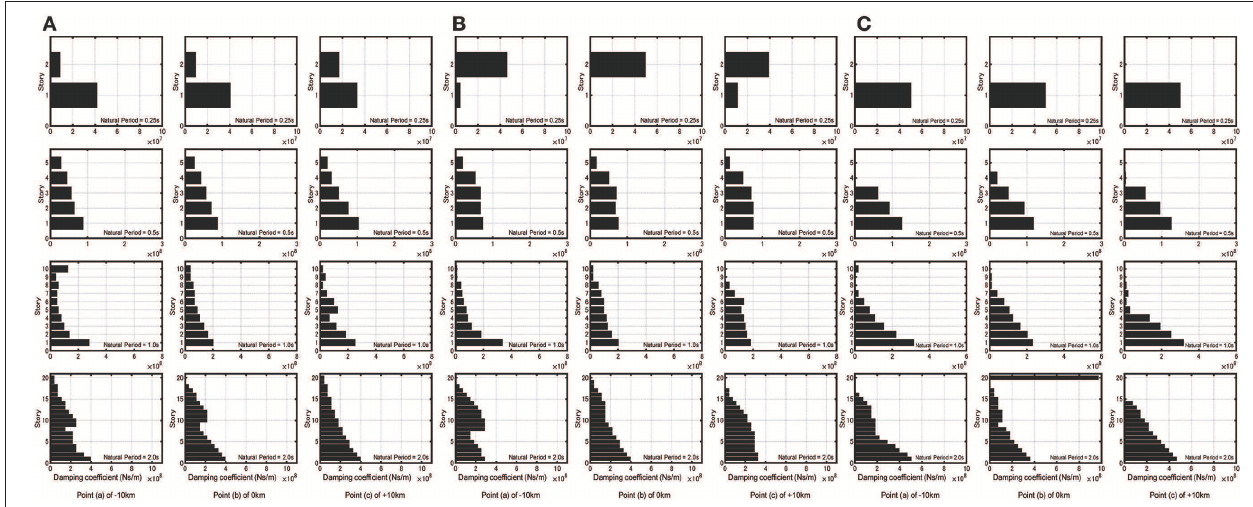
FIGURE 11 | Critical damping coefficient distributions of four MDOF models with different number of stories ( T 1 = 0.25 s , 0.5 s , 1.0 s , 2.0 s ) at three points. (A) Model with straight lowest natural mode. (B) Model with trapezoidal stiffness distribution. (C) Model with uniform stiffness distribution.